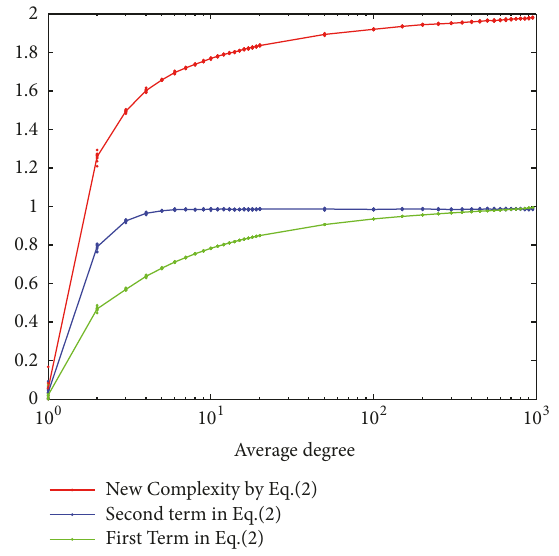
Figure 4: Complexity computed using (2) (red), second term in (2) (blue), and first term in (2) (green) as a function of the average degree of the graph. Each graph has 1000 nodes.